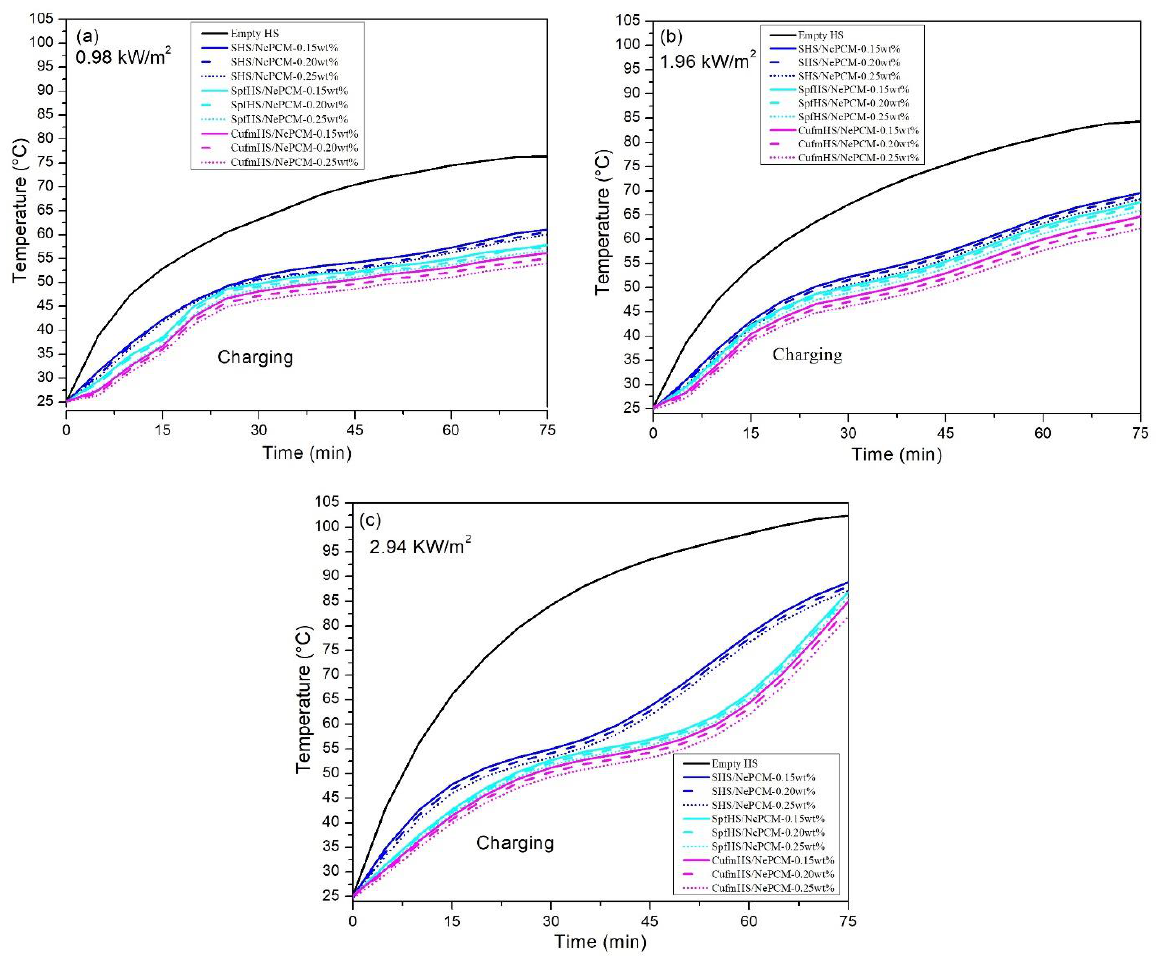
Figure 7. Various HSs time-temperature behavior at heat fluxes ( a ) 0.98 kW · m − 2 ( b ) 1.96 kW · m − 2 ( c ) 2.94 kW · m − 2